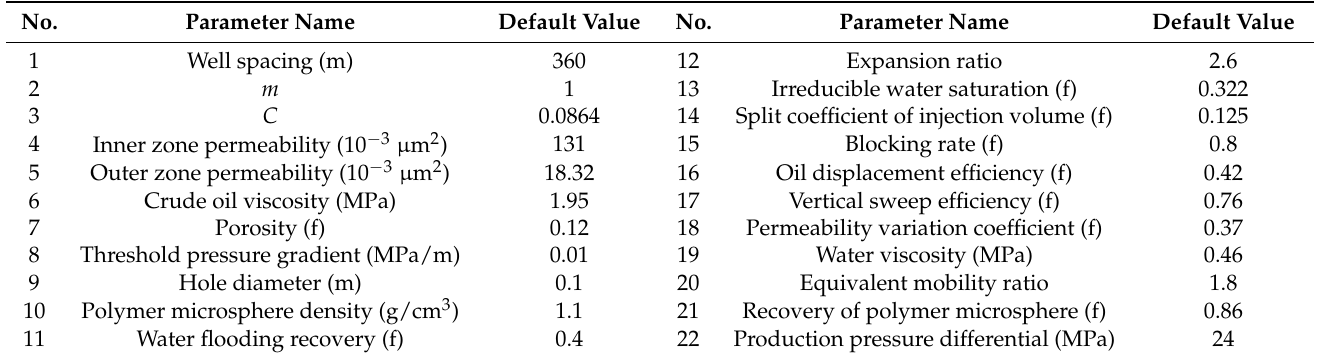
Table 3. Reservoir and fluid properties.